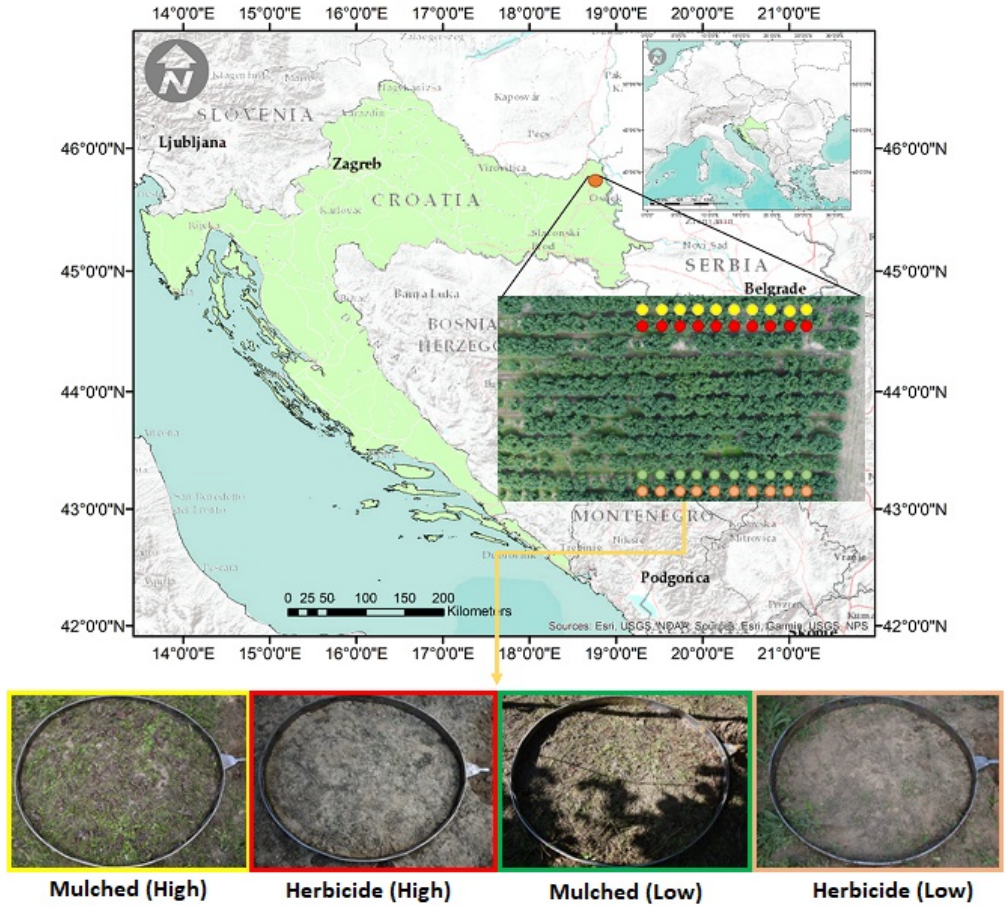
Figure 1. Study area and experimental design.